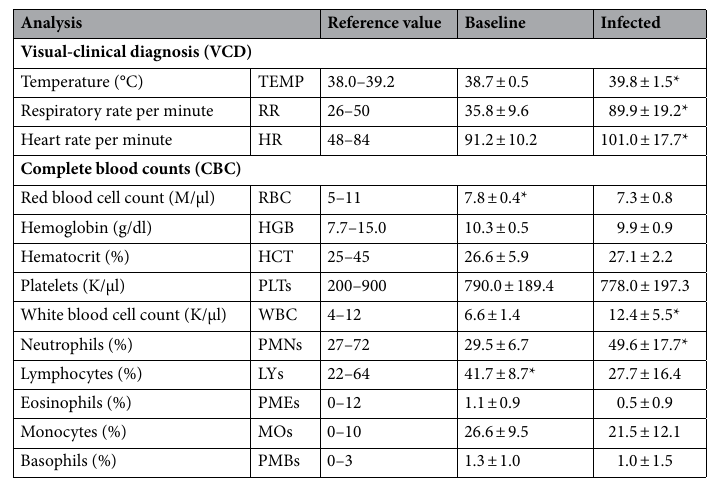
Table 3. Clinical and hematological values (Mean ± SD) compared to reference for dairy calves challenged with M. haemolytica . Data were analyzed using Student’s t-test between the groups with an α < 0.05 delineating